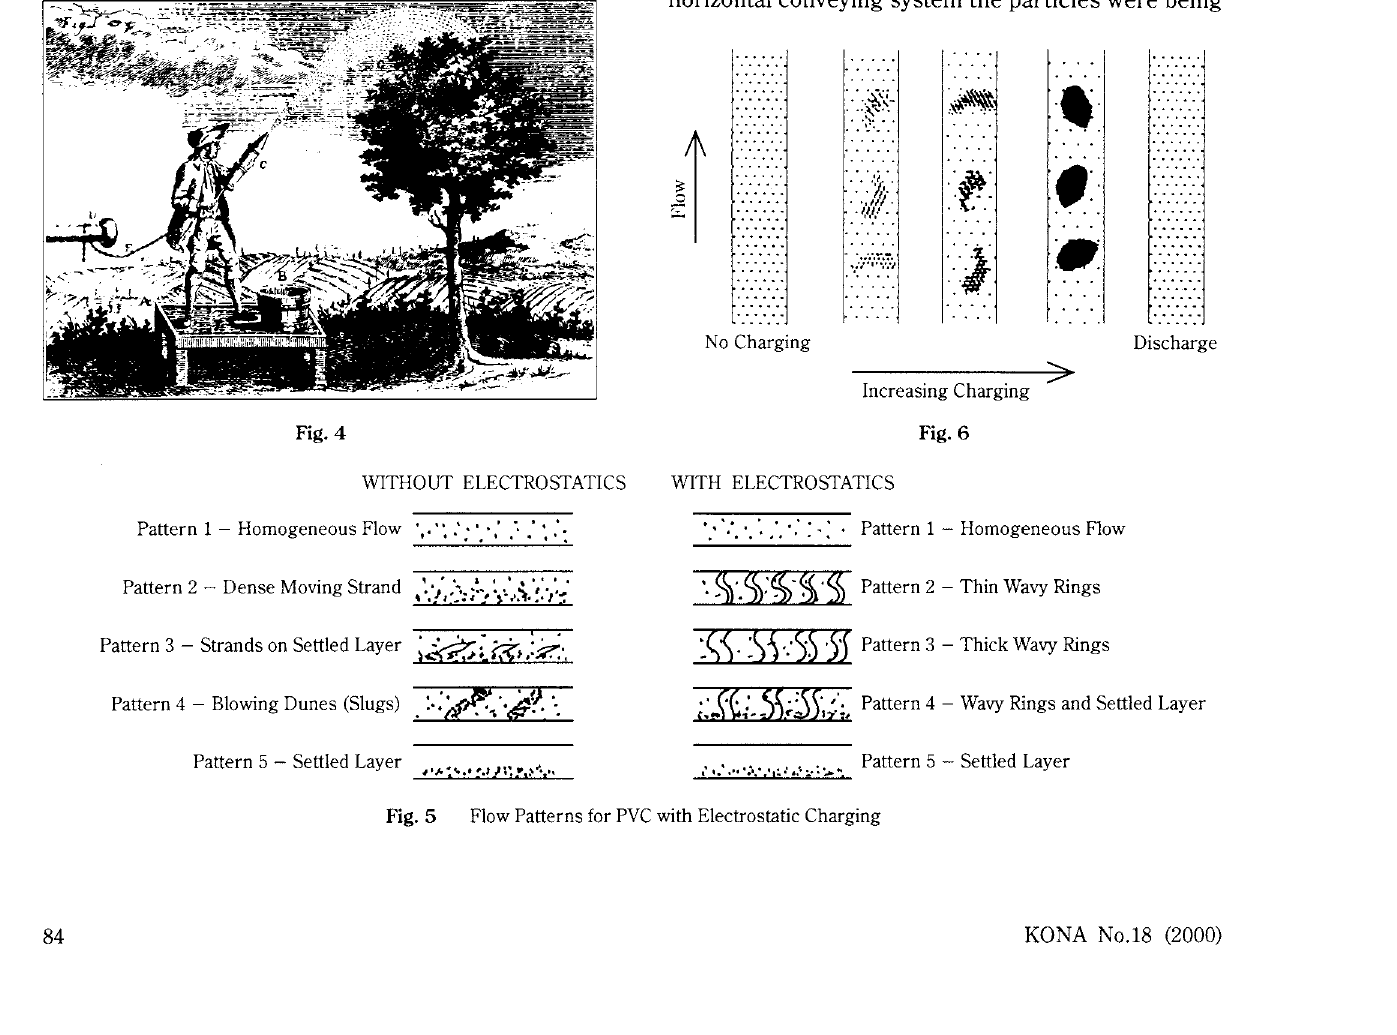
WITHOUT ELECTROSTATICS